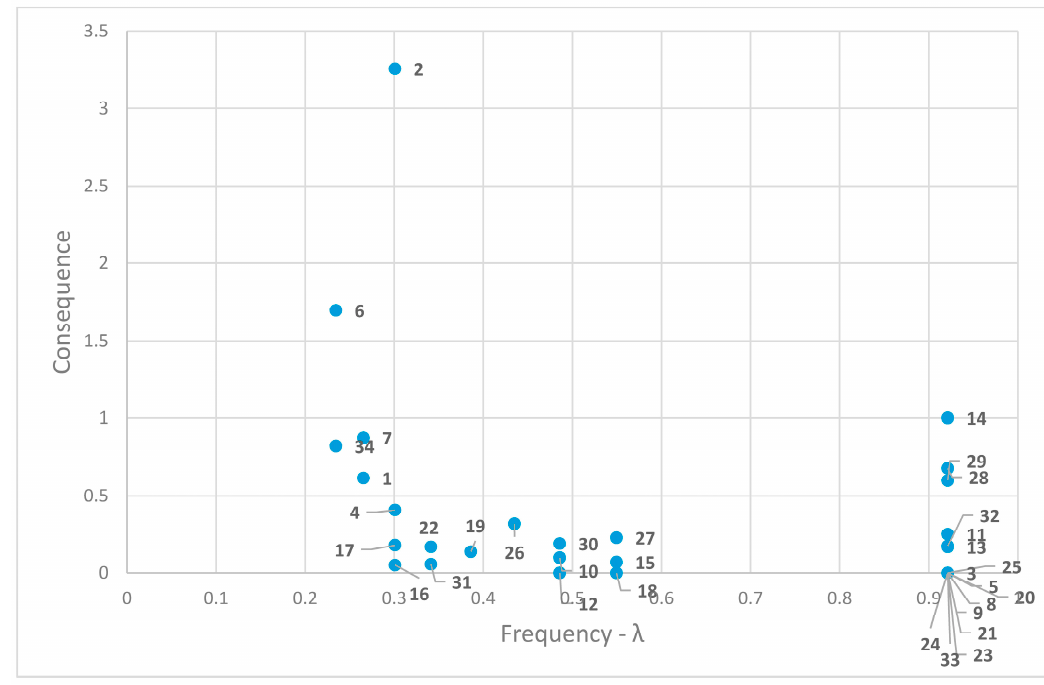
Figure 3. Frequency of break and relative consequence.